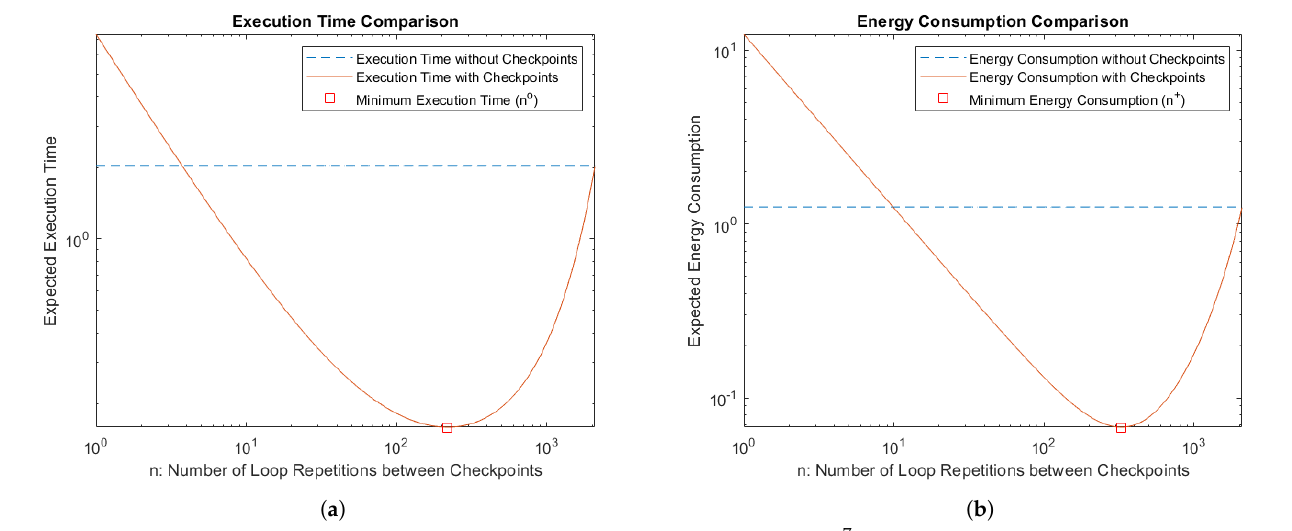
Figure 10. The case of a software program with a relatively large loop (i.e., Y = 10 7 ): ( a ) Expected execution time comparison (logarithmic axes) ( b ) Expected energy consumption (logarithmic